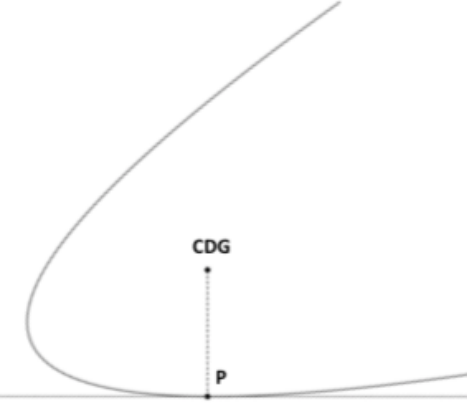
Figure 2. Position of the center of gravity.